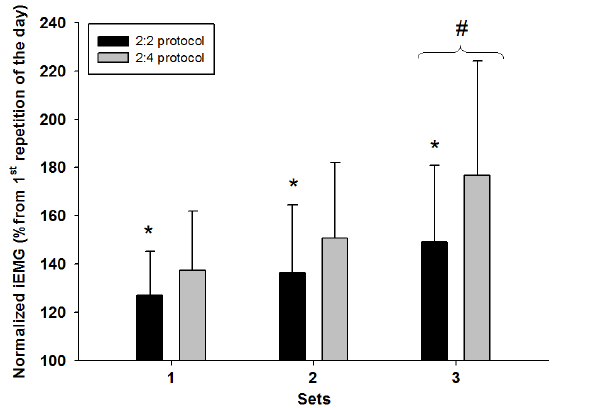
Figure 2. Mean normalized iEMG of the triceps brachii muscle for each training protocol (values normalized using the 1st repetition of the day).